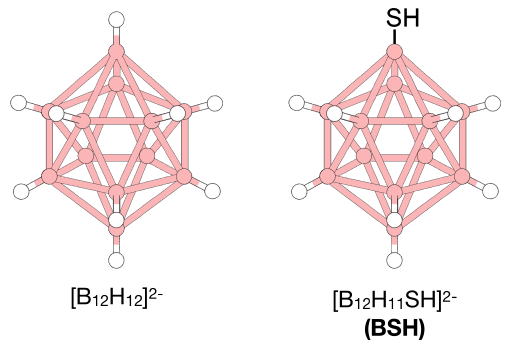
Figure 18. Schematic view of the [B 12 H 12 ] 2 − anion vs. the [B 12 H 11 SH] 2 − anion component of the BNCT agent, sodium borocaptate (BSH, Na 2 B 12 H 11 SH). Pink spheres denote boron atoms and white spheres denote hydrogen